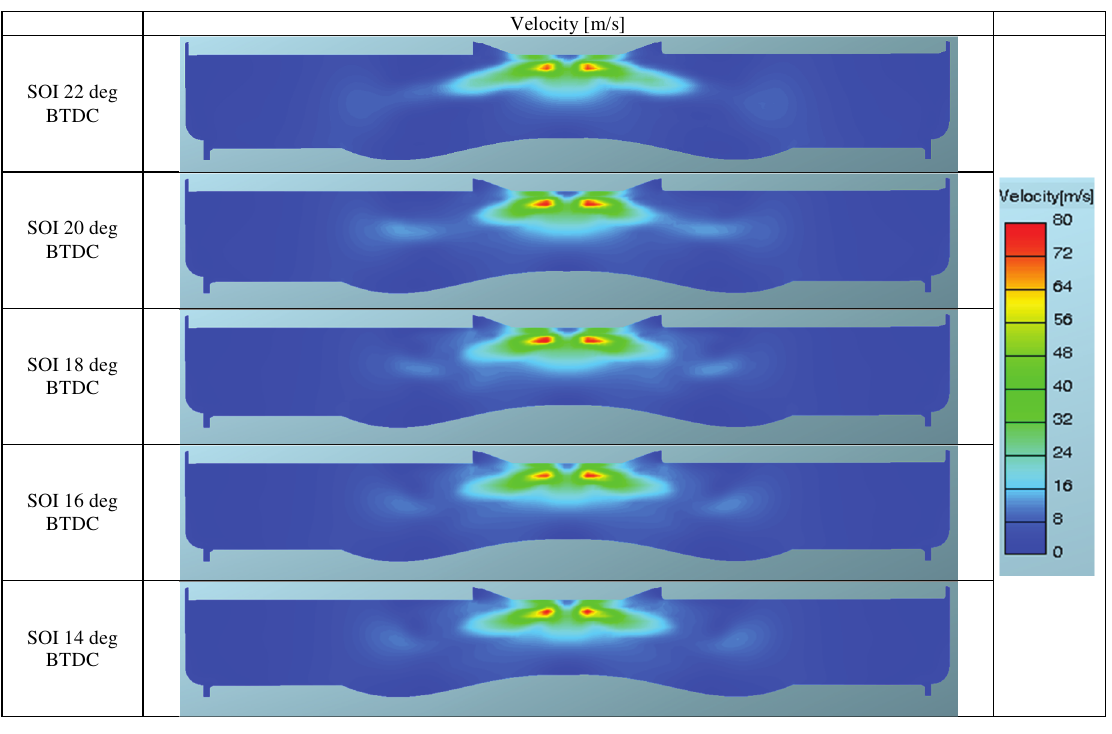
Fig. 4. Velocity distribution of gases in the combustion chamber at 12 degrees of the crankshaft position after the SOI